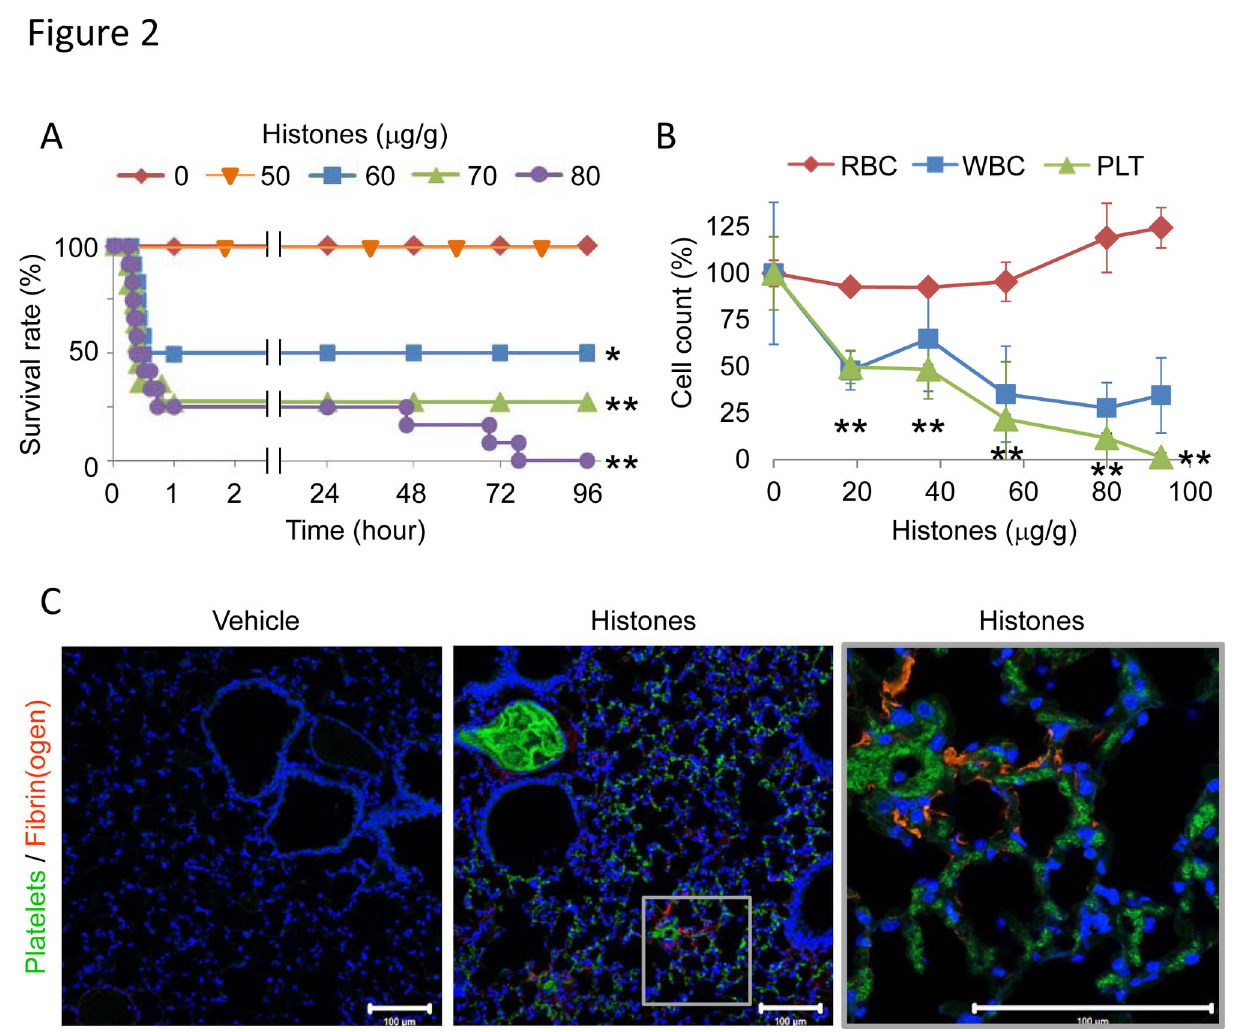
Figure 2. Extracellular histones cause fatal thromboembolism in mice. (A) The lethal effect of extracellular histones. Mice were intravenously injected with histones (0-80 µg/g, n = 7-12 per group), and survival was analyzed. (B) Histone-induced thrombocytopenia. Numbers of platelets (PLT), red blood cells (RBC), and white blood cells (WBC) in blood 10 min after infusion with histones (0-95 µg/g, n = 3-7 per group, mean ± S.D.) are shown. Data are presented as percentage of the vehicle group (0 µg/g histones). (C) Distribution of DyLight488-labeled platelets and Alexa-Fluor 594-labeled fibrin(ogen) in lung tissue 10 min after infusion with vehicle or 75 µg/g histones. Nuclei were stained with DAPI. Representative images of n = 4. Scale bar = 100 µm. * P < 0.05 and ** P < 0.01 compared with the vehicle